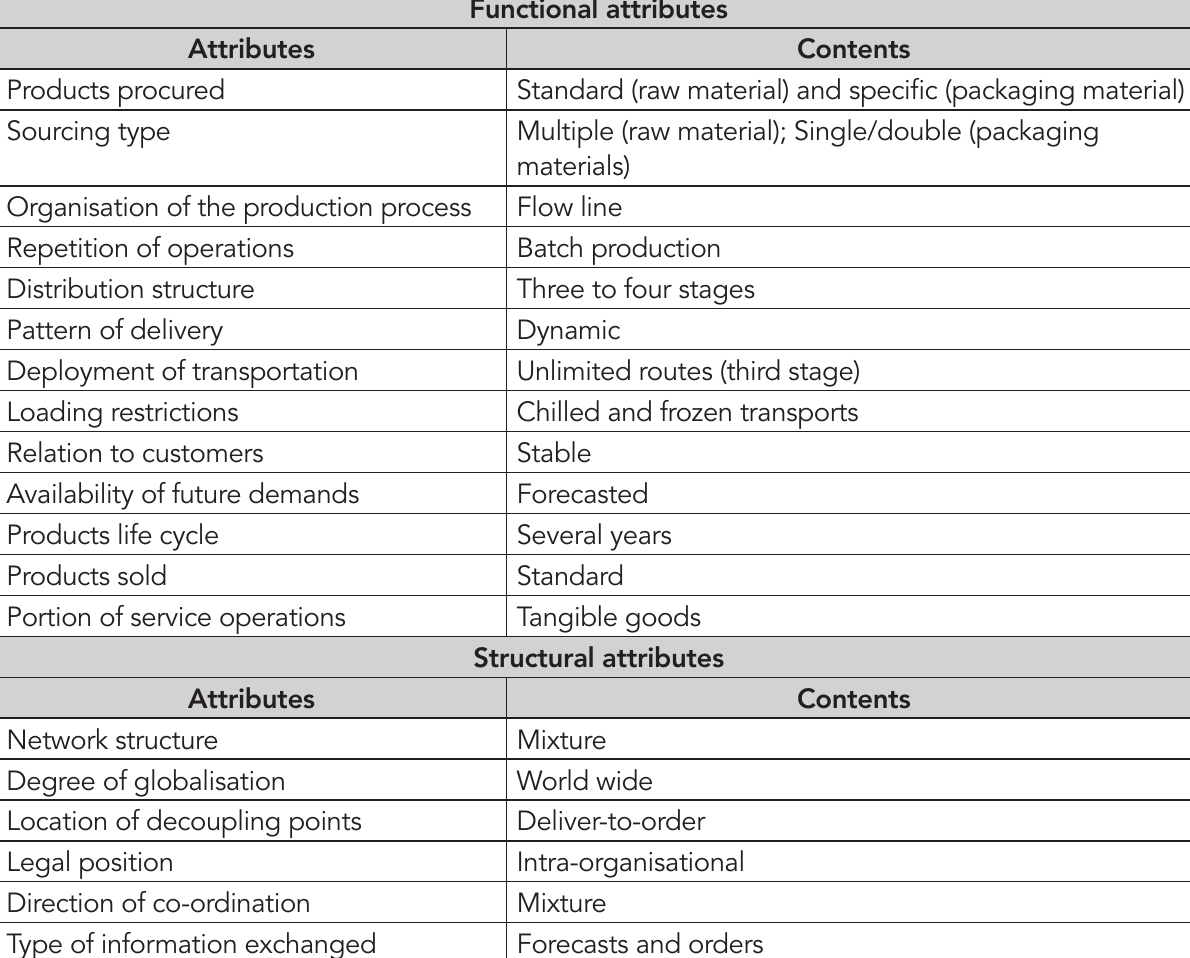
Table 1: Typology for FMCG supply chain (Kumar,